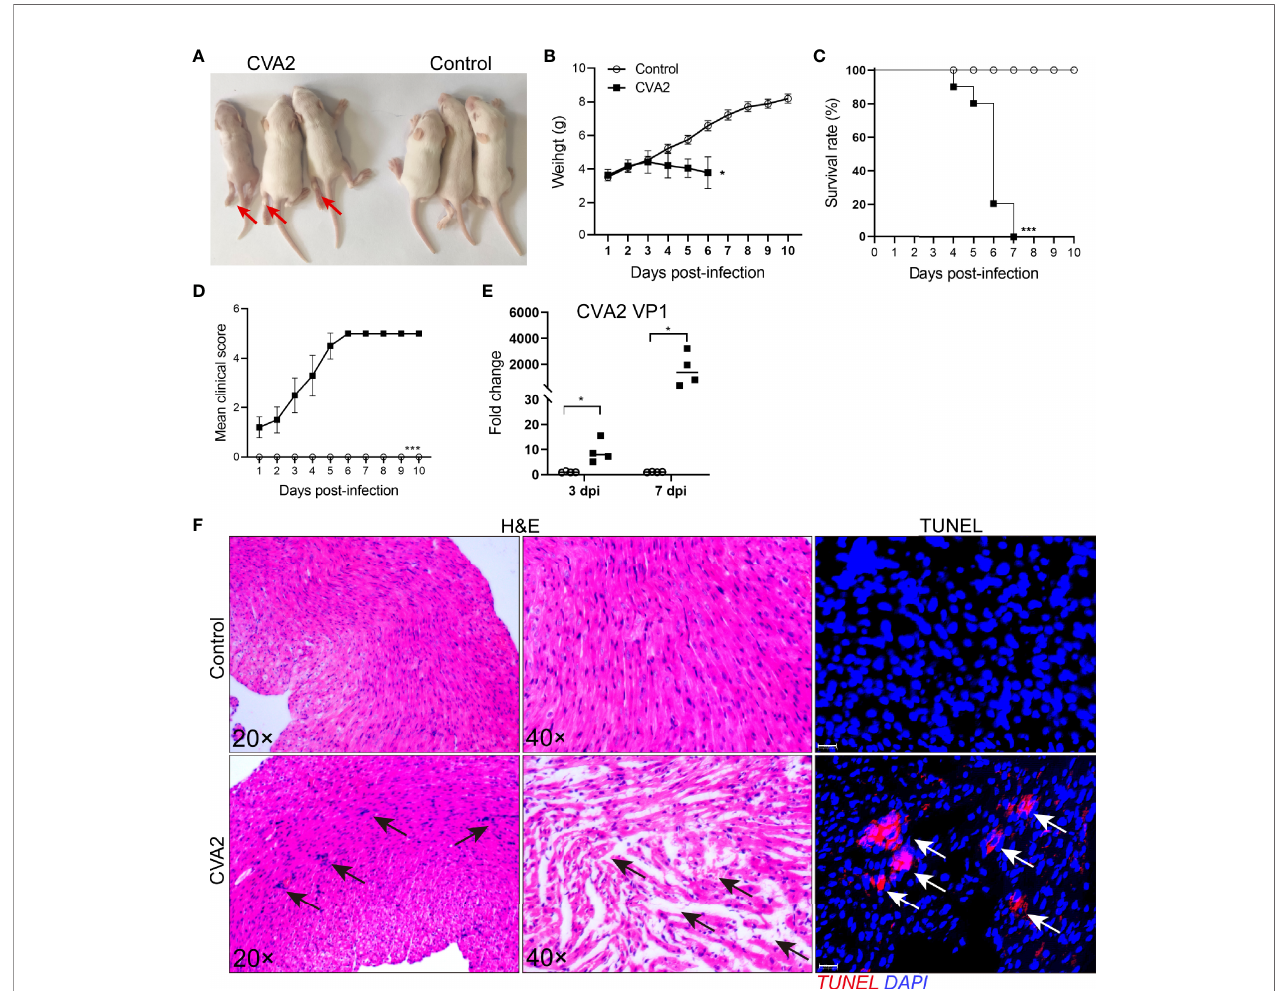
FIGURE 1 | CVA2 infection leads to heart injury in a neonatal mouse model. (A) Symptoms of CVA2-infected mice at 5 dpi. The body weight (B) , survival rate (C) , and clinical scores (D) of Control (n=10) and CVA2-infected mice (n=10) were recorded from 1 dpi to 10 dpi. Viral titers (E) in heart tissues of mice represented by the fold change of VP1 mRNA were detected by qRT-PCR (n=4). Histopathological changes (F) in heart slices of mice were evaluated by H&E staining and TUNEL staining. Red arrows indicate limb paralysis of infected mice. Black arrows indicate in fl ammatory cell in fi ltration, myocardial fi ber breakage, myocardial interstitial edema, and white arrows indicate apoptotic cells in heart slices of infected mice. *p < 0.05; ***p <